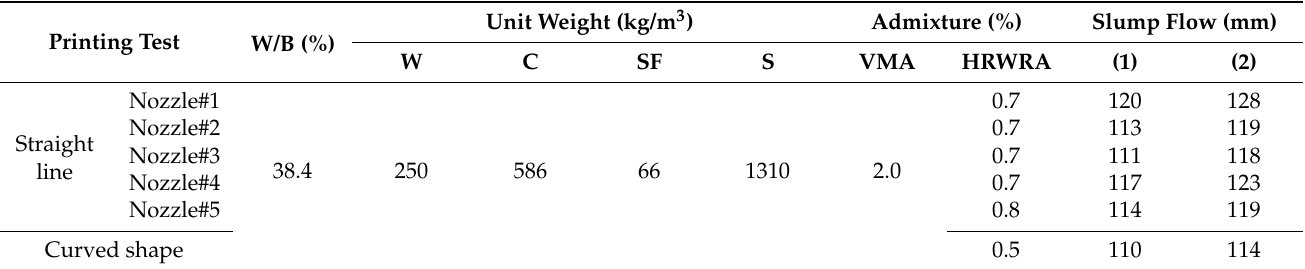
Table 3. Mixture proportioning and test results of slump